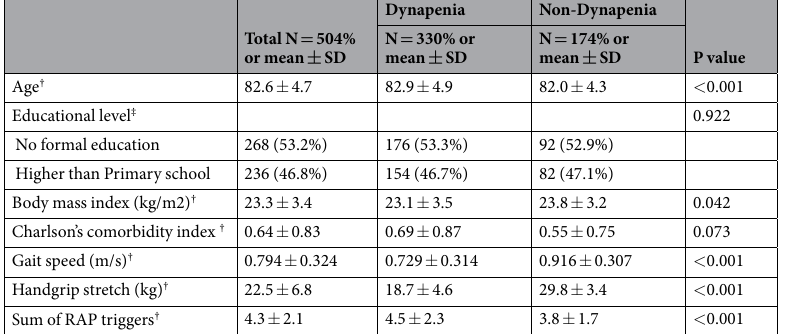
Table 1. Subjects’ demographic and anthropometric characteristics with or without dynapenia * . Values presented as † mean ± standard deviation; ‡ number (%). * Defined by EWGSOP criteria (European Working Group on Sarcopenia for Older People, 2010 17 ). DLMS: Based on Handgrip strength < 26 kg. RAP: Resident Assessment